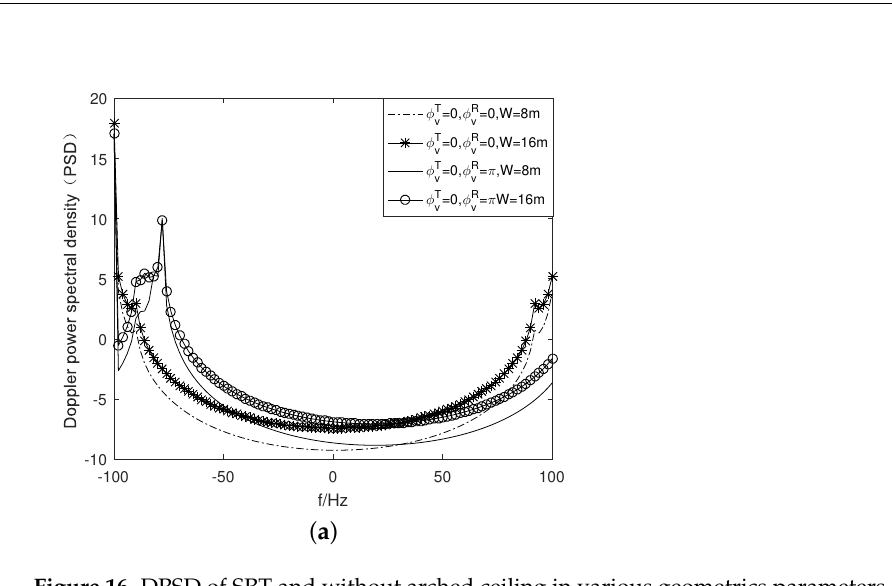
Figure 16. DPSD of SRT and without arched ceiling in various geometrics parameters. ( a ) DPSD of SRT. ( b ) DPSD of SRT without